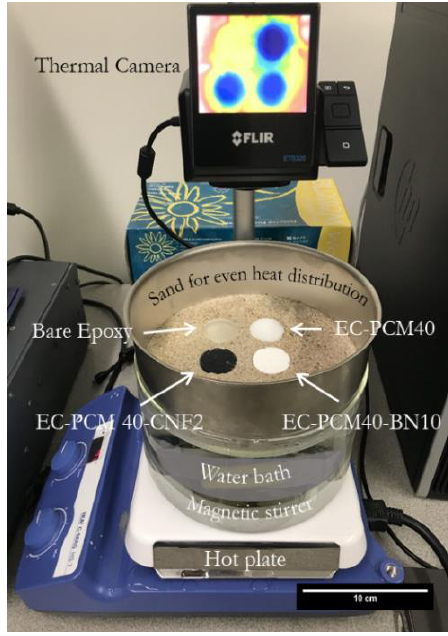
Figure 9 . A photograph showing the sand-bath experimental setup used to measure the temperature vs. time profiles of the bare epoxy, EC-PCM40, EC-PCM40-CNF2, and EC-PCM40-BN10 samples.